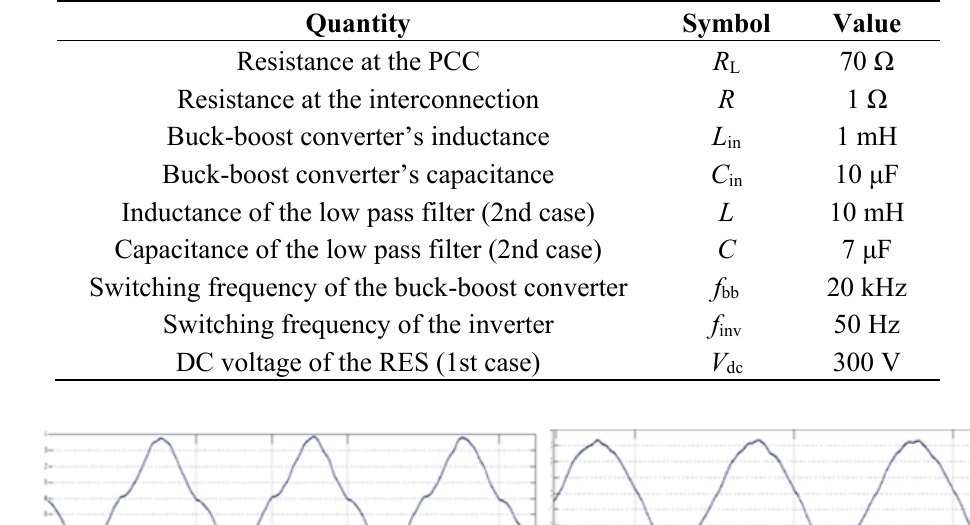
Table1. Control and circuitry parameters of the studied system.